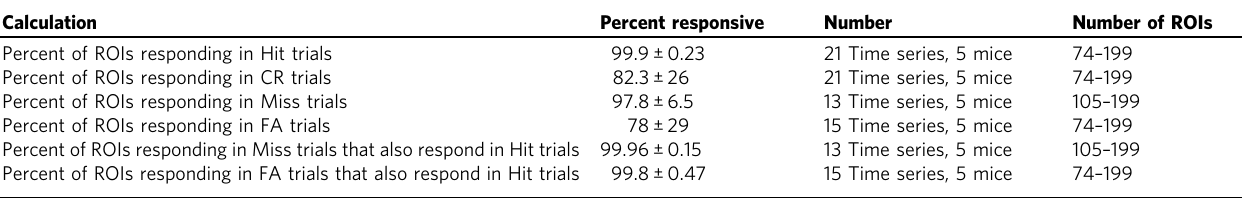
Table 1 Percent of ROIs displaying a change in Δ F / F during odorant